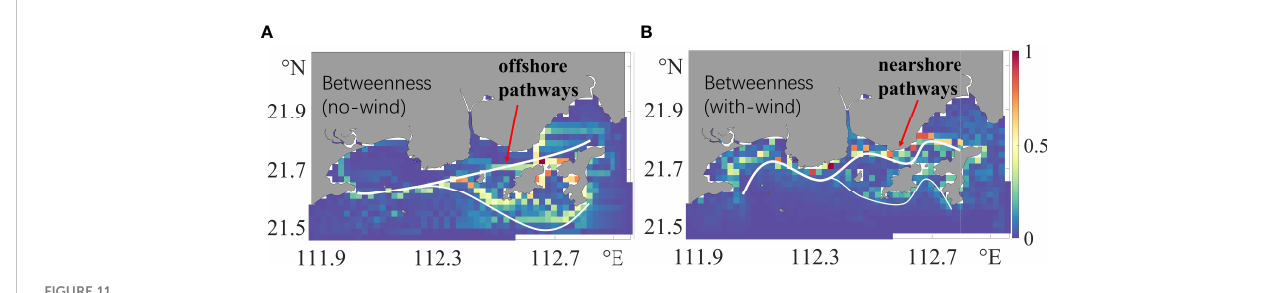
FIGURE 11 The betweenness pathways with wind in March (B) and without wind (A) .